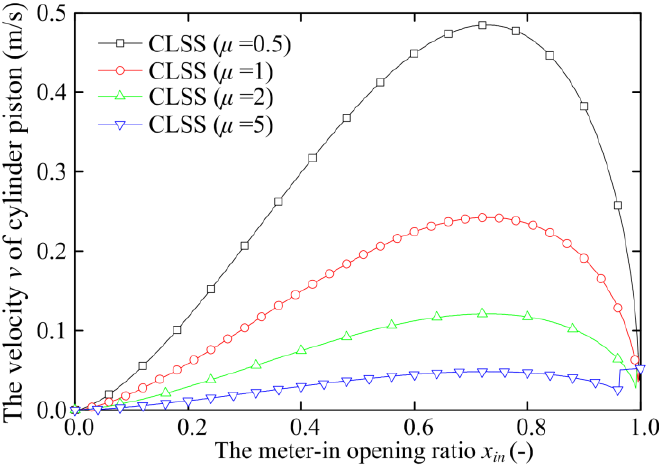
Figure 22. The velocity v of the cylinder piston of CLSS with retraction working mode.